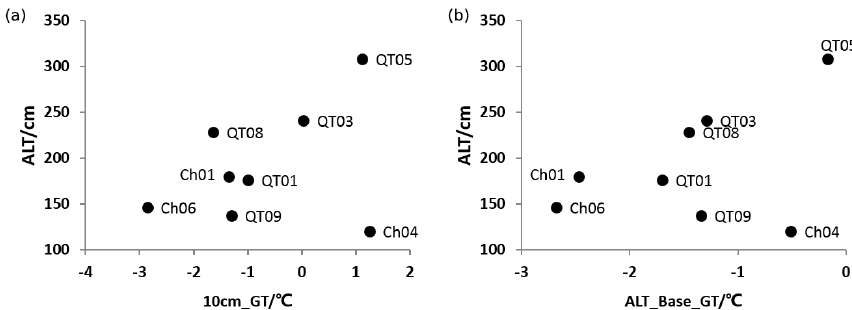
Figure 8. The relationship between active layer thickness and the temperature of the permafrost table.